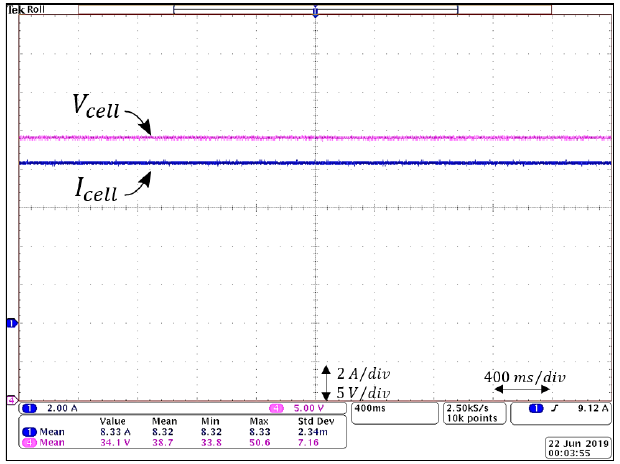
Figure 10. V cell and I cell waveforms corresponding to the B point operating point in Figure 8.